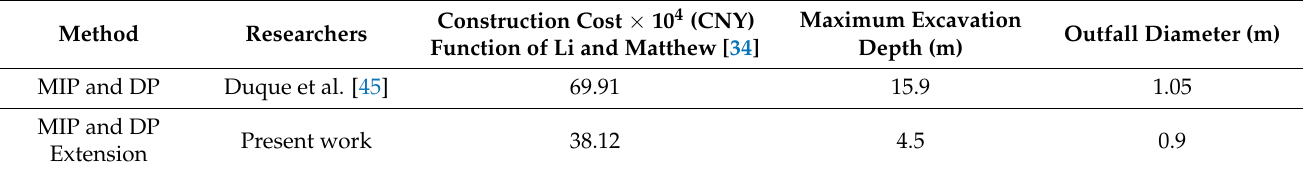
Table 8. Construction cost with different methods for the benchmark proposed by Duque et al. [45].